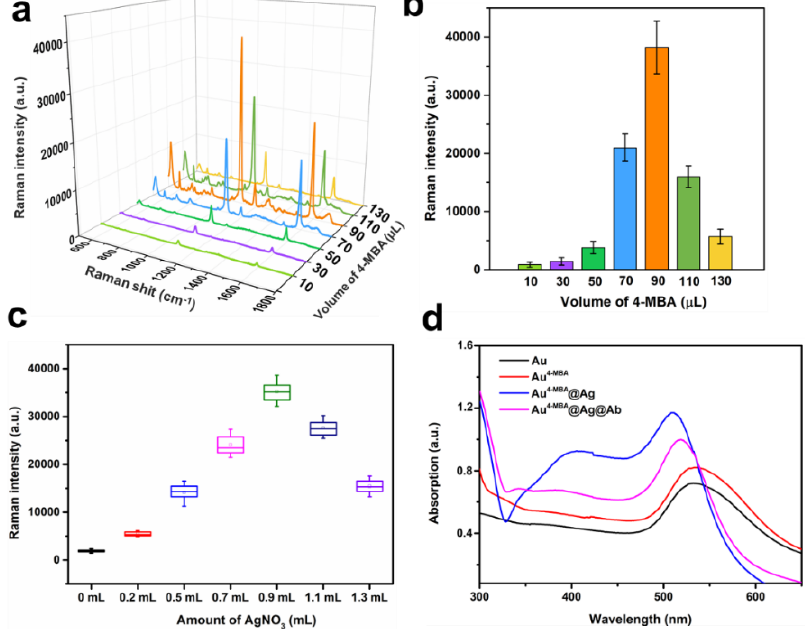
Figure 3. ( a ) Raman spectra and ( b ) Raman intensities at 1076 cm − 1 of different amounts of 4-MBA; ( c ) Raman intensities at 1076 cm − 1 of different amounts of AgNO 3 ; ( d ) UV-VIS extinction spectra of Au, Au 4-MBA , Au 4-MBA @Ag, and Au 4-MBA @Ag@Ab. For the preparation of Au 4-MBA @Ag SERS nanotags, ascorbic was acted as a reductive agent mixed with Au 4-MBA colloid. Thereafter, AgNO 3 was added dropwise under mag- netic stirring. As a result, the Ag (+) in the AgNO 3 solution was reduced to Ag (0) and was